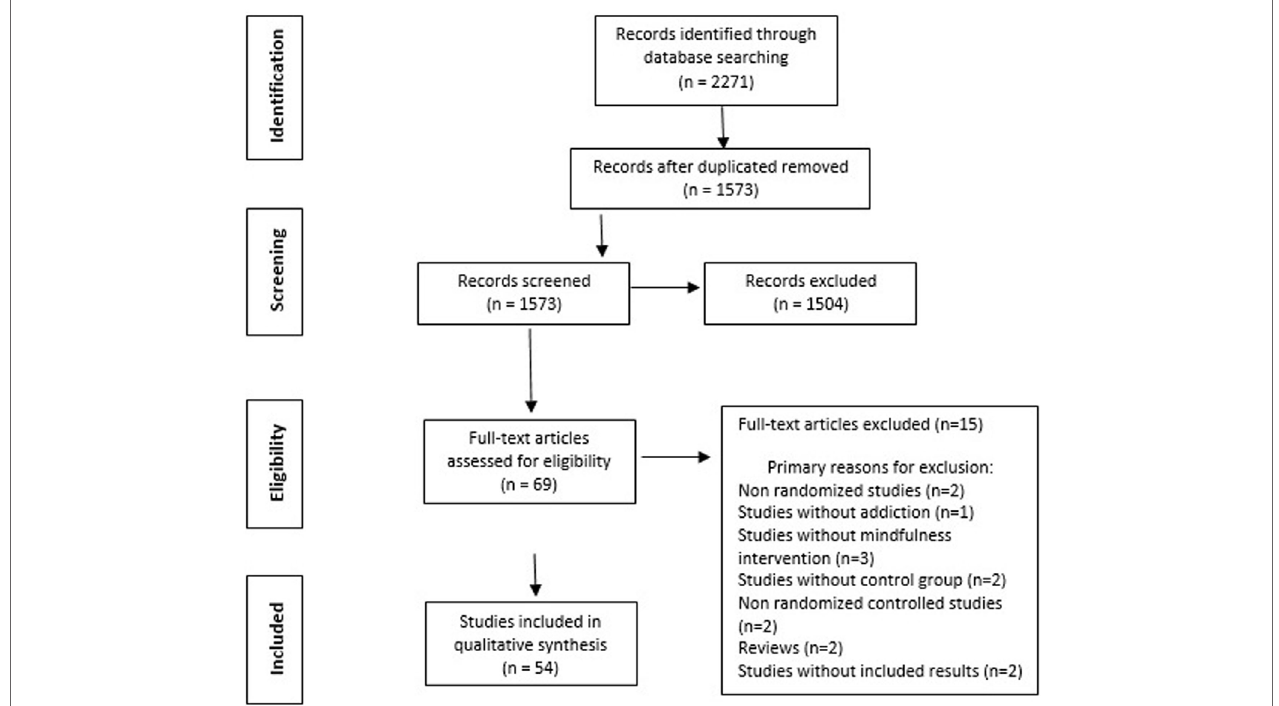
FiGURe 1 | Preferred Reporting Items for Systematic reviews and Meta-Analyses flow chart of literature